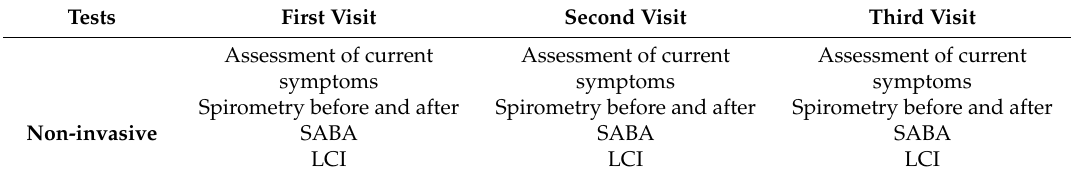
Table 3. Invasive airway